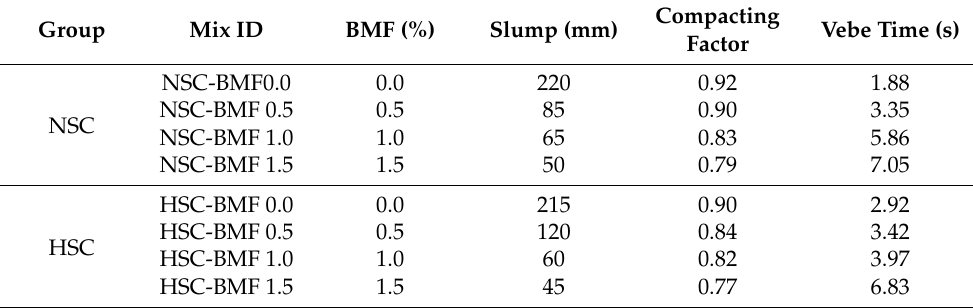
Table 6. Workability test results of concrete mixtures.